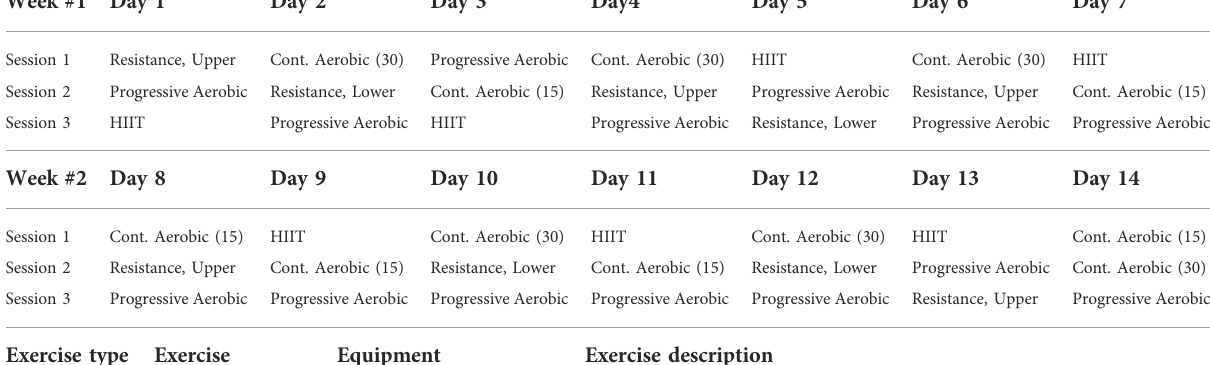
TABLE 2 Proposed exercise countermeasure protocol for the bedrest study in older adults.